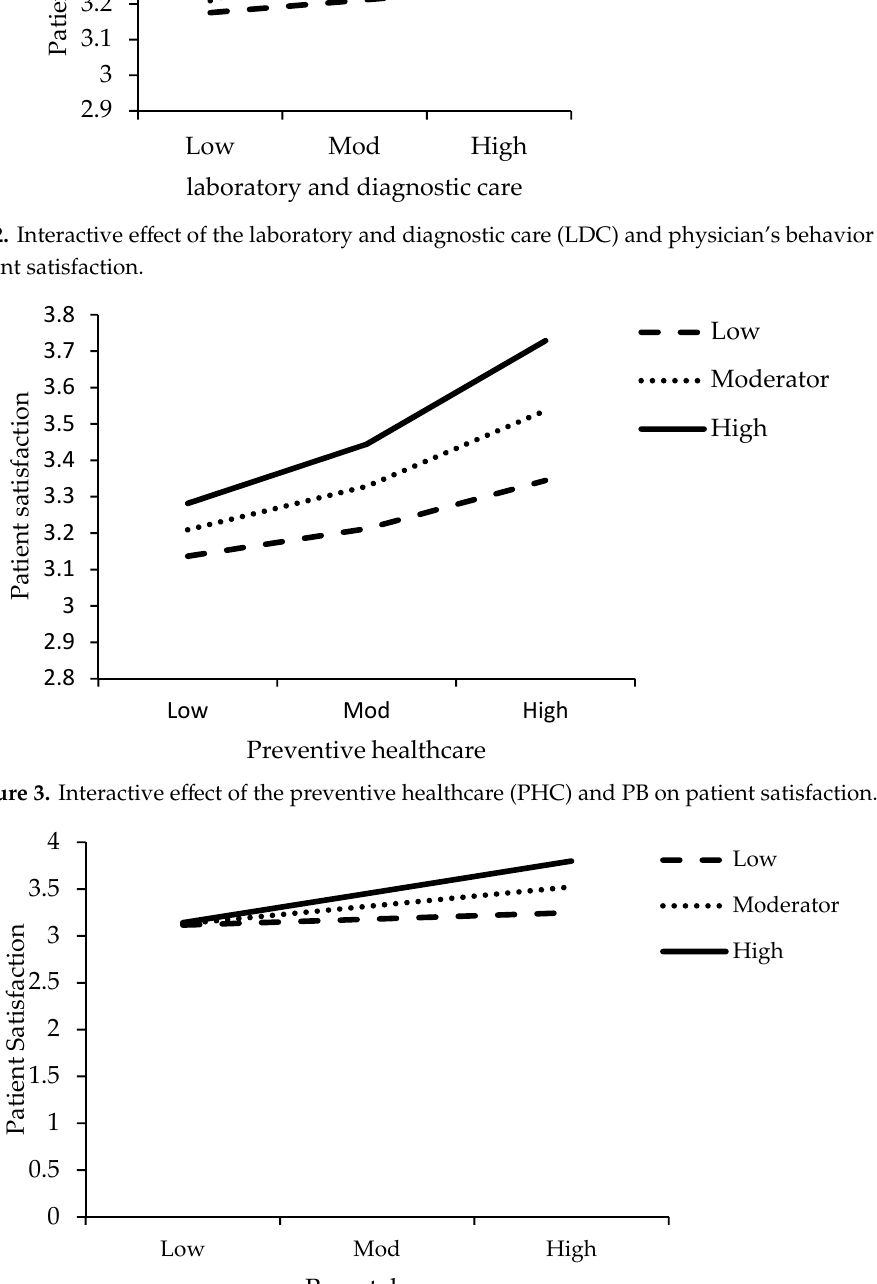
Figure 4. Interactive effect of the prenatal care (PC) and PB on patient satisfaction.